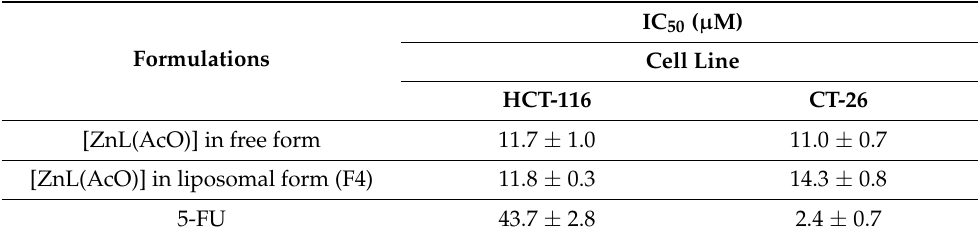
Table 3. In vitro antiproliferative effect of [ZnL(AcO)] in its free and liposomal forms and the positive control 5-FU against the colon cancer cell lines HCT-116 and